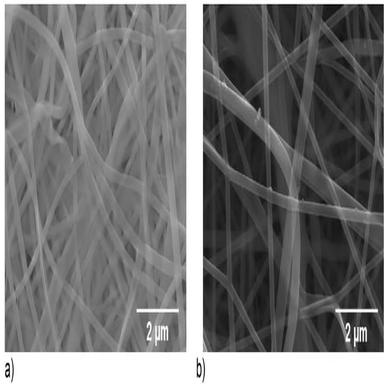
SEM micrographs (SE-mode) of the as-spun fibers a) 3Y–Zr and b) 10Mg–Zr.